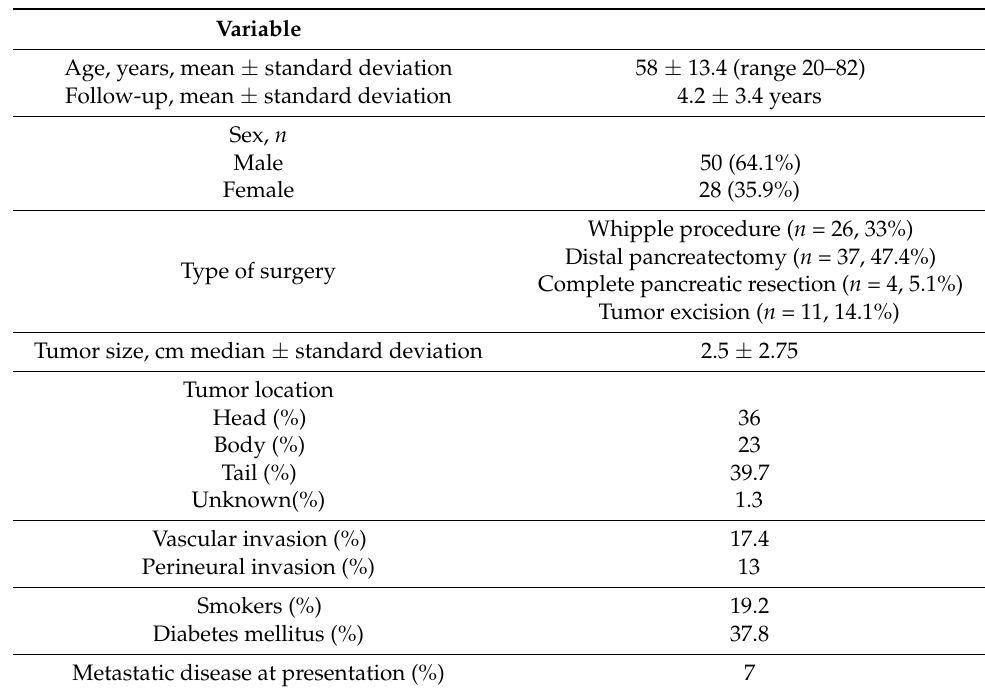
Table 1. Demographics of the study cohort.